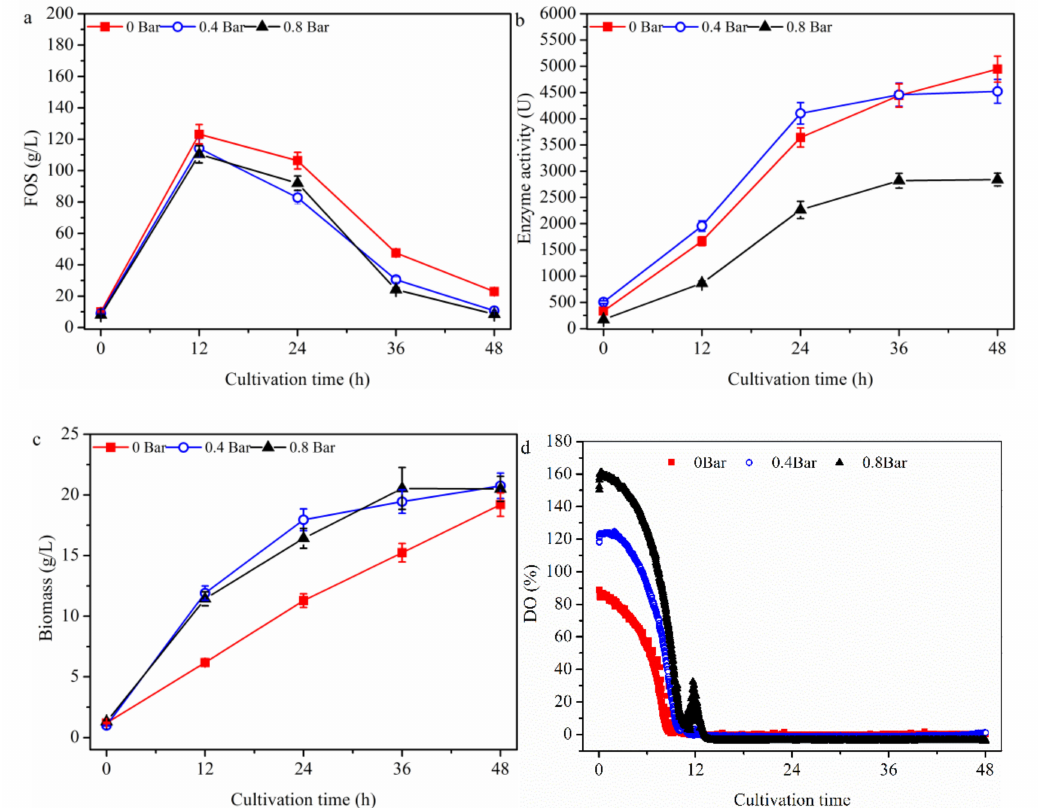
Figure 4. Time profiles of the batch cultivation at different partial pressures of the bioreactor. The A. pullulans ipe-3 strain was cultivated in a 2.7 L bioreactor at pH 5.5, aeration rate 1.8 L/min, and 25 ◦ C with different fermenter pressures. The time courses refer to ( a ) FOS, ( b ) enzyme activity, ( c ) biomass, and ( d ) DO. The working volume was 1.8 L. Data are given as the mean ± SD, n =